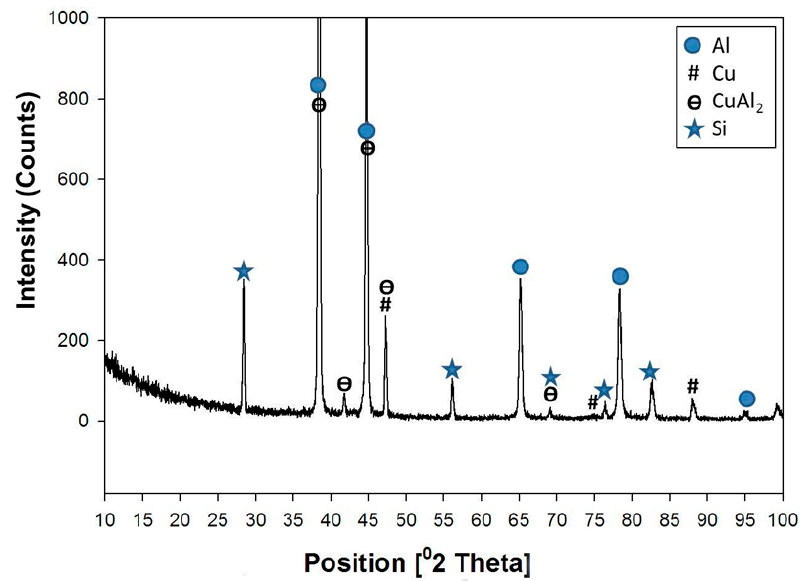
Figure 4. XRD patterns obtained from of the formed composite after addition of 6% Cu.